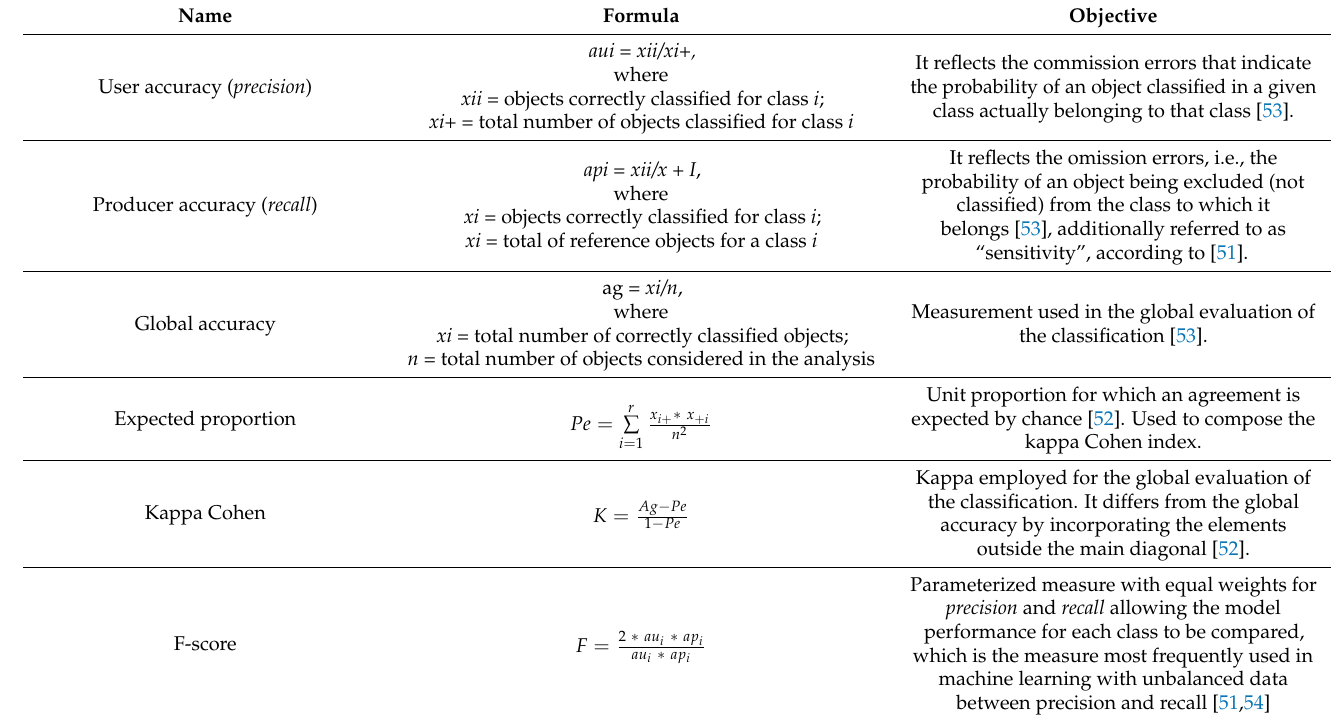
Table 3. Formulas used to evaluate